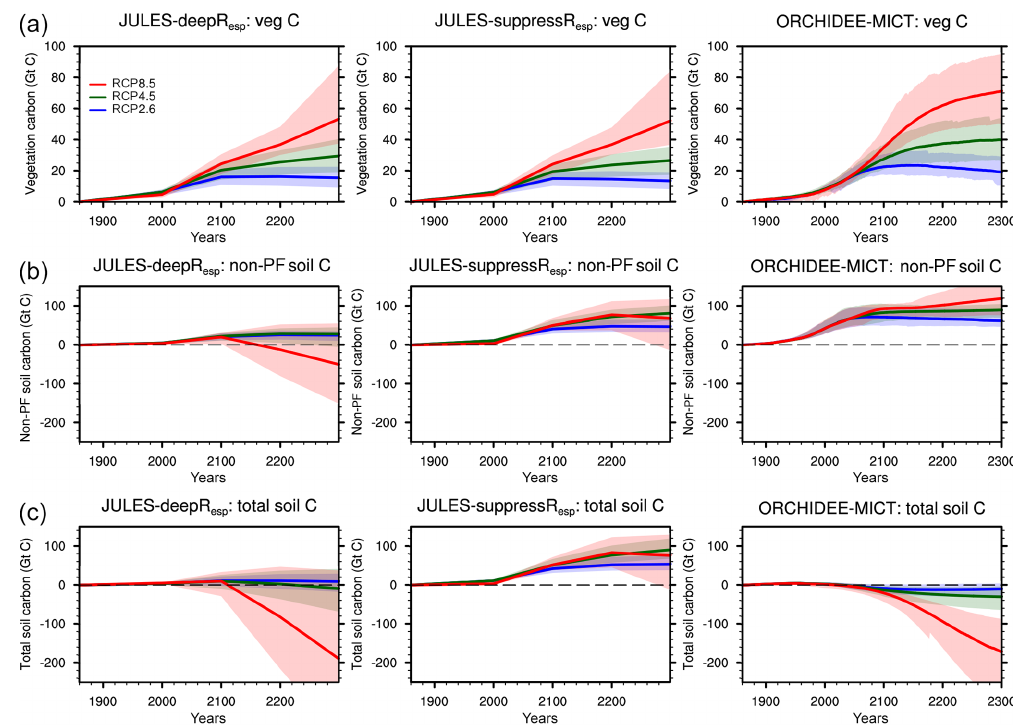
Figure 5. The change in the vegetation carbon (a) non-permafrost soil carbon (non-PF; b ) and total soil carbon (c) , all for polewards of 60 ◦ N. The vegetation carbon and change are the same in JULES-suppressR esp and JULES-deepR esp